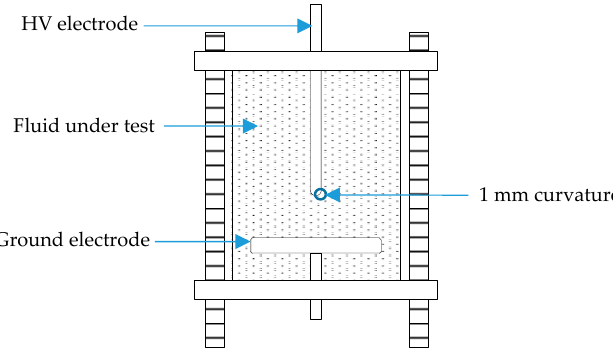
Figure 2. Schematic diagram of the test chamber for PD measurement.